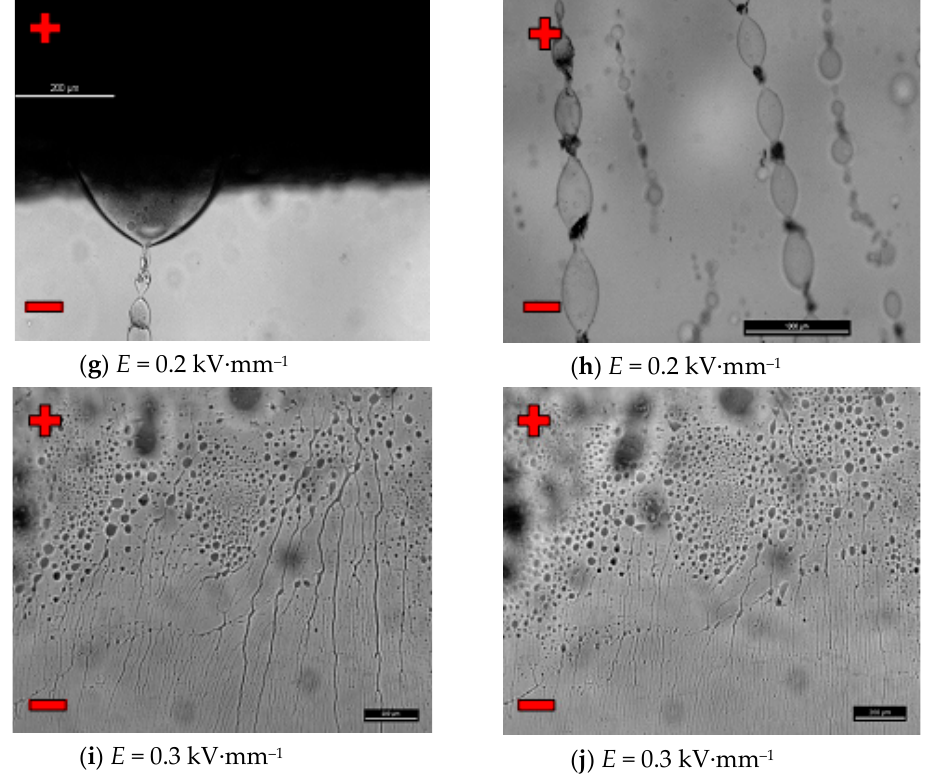
Figure 14. ( a – j ): Mixture PAO6 + CJ008 in an electric field observed under Nikon Eclipse LV100D pola-rizing microscope.